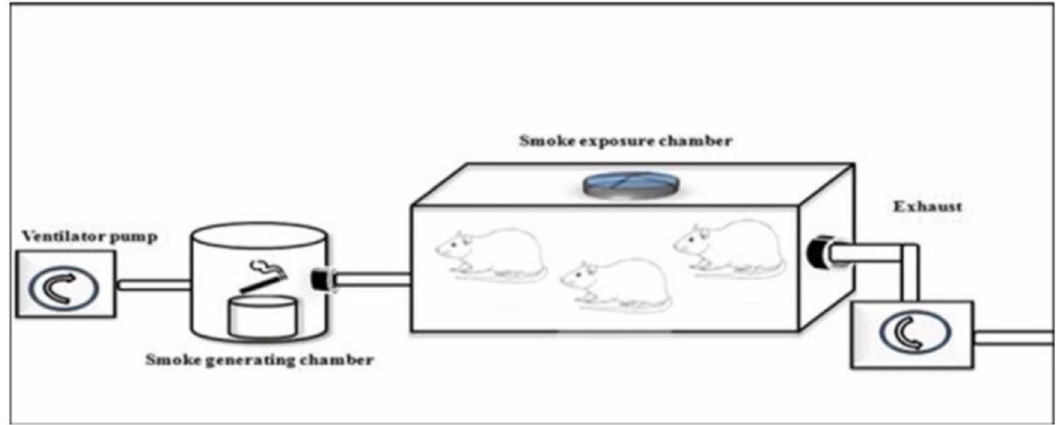
Figure 2. Illustration of smoking chamber for rats.